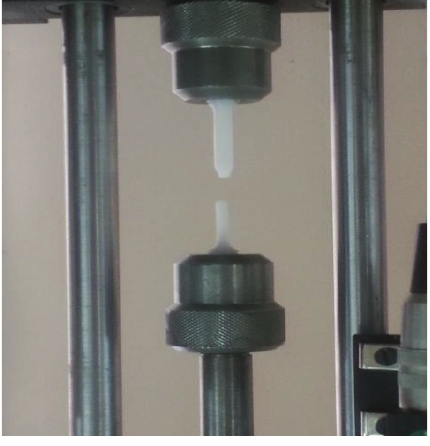
Figure 3: Ruptured specimen.